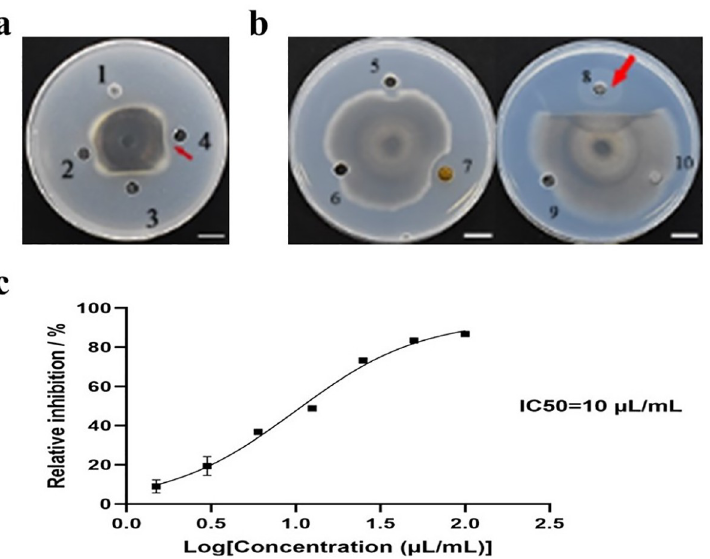
Fig 1. Isolation and IC50 of active components in the ZW10 cell-free culture filtrate extracted by different organic solvents (a, 1–4: N-hexane extract, dichloromethane extract, ethyl acetate extract, and N-butanol extraction), and the activity of various fractions of ethyl acetate extract in the CH 2 Cl 2 /MeOH system (b, 5–10 fractions were: 0% MeOH, 20% MeOH, 40% MeOH, 60% MeOH, 80% MeOH, and 100% MeOH). (c), IC50 of the 60% MeOH extraction against M . oryzae . Data are presented as means of three replicates ± SD. Scale bar, 10 mm.